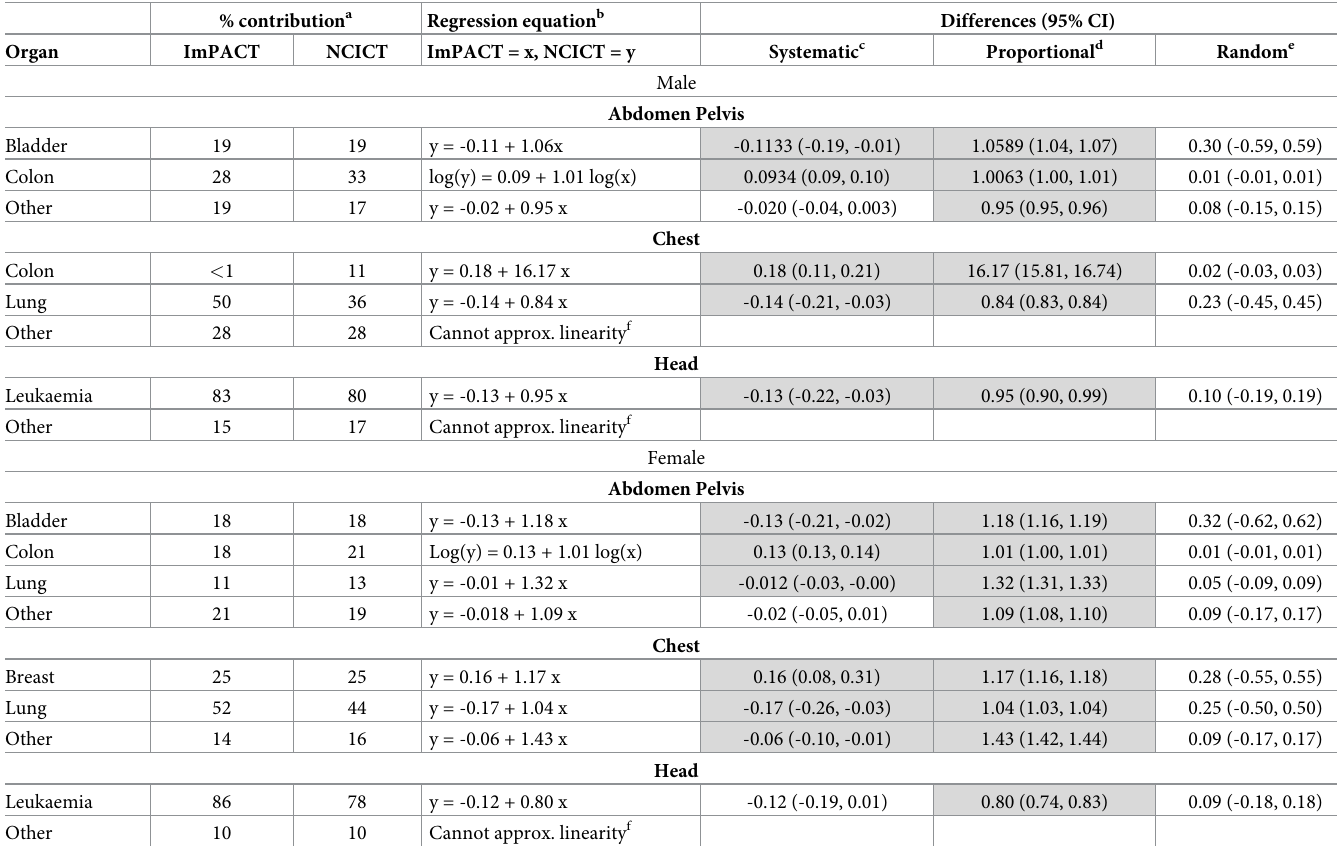
Table 2. Passing Bablok regression–Comparison of median organ equivalent doses as estimated by ImPACT and NCICT for each protocol (abdomen pelvis, chest and head) for those organs that contribute > 10% to total cancer incidence (averaged over ages 18–80) for a) males and b) females. % contribution